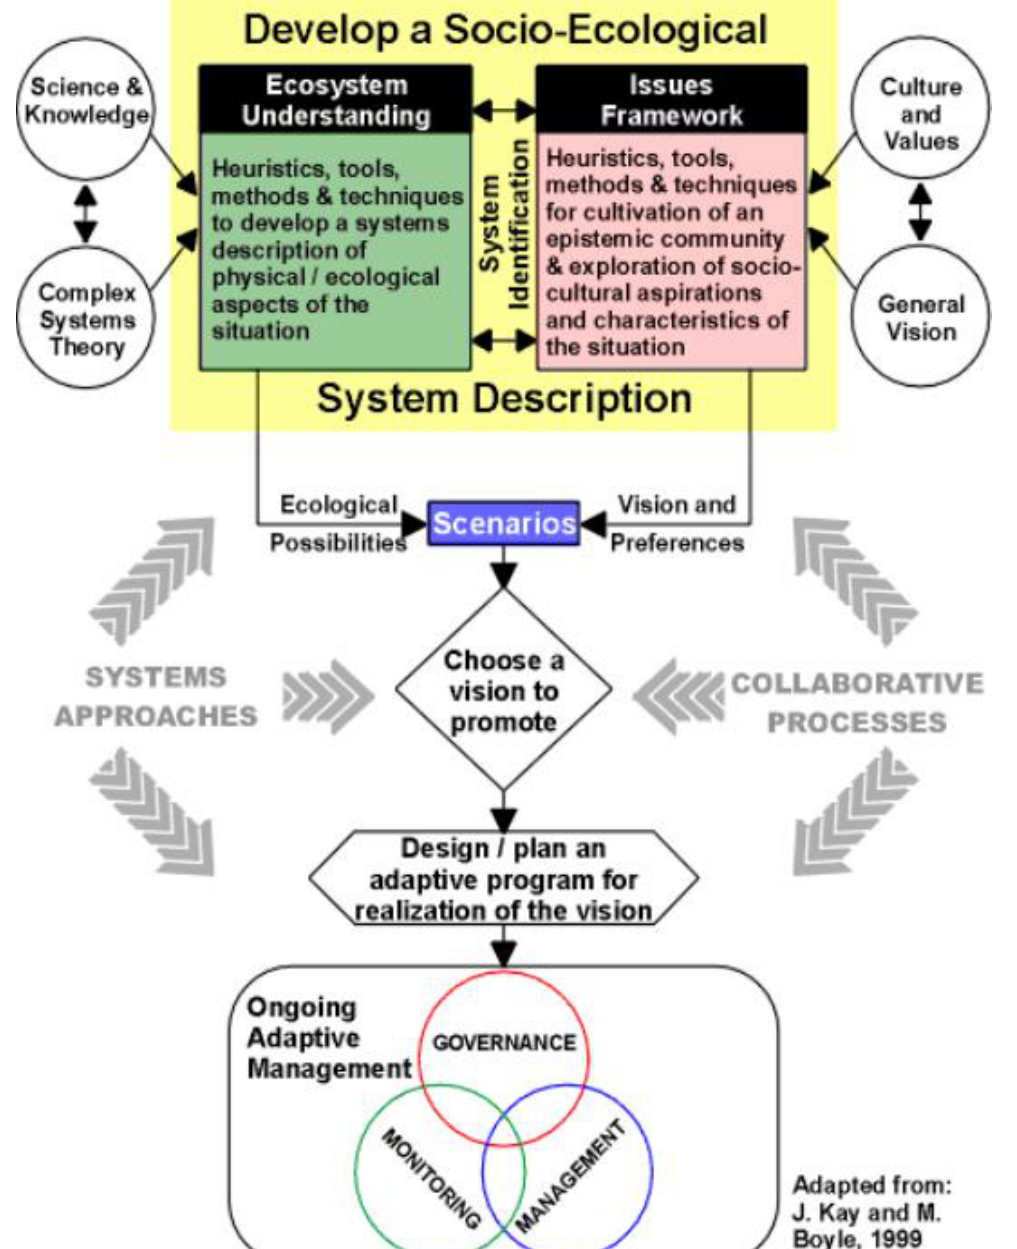
Fig. 1. One version of the "diamond" heuristic of the ecosystem approach adapted from Kay and Boyle (1999). It shows how scenarios, visions, and managing for sustainability emerge from the integration of ecological and sociocultural understanding. Other versions of this figure can be accessed at